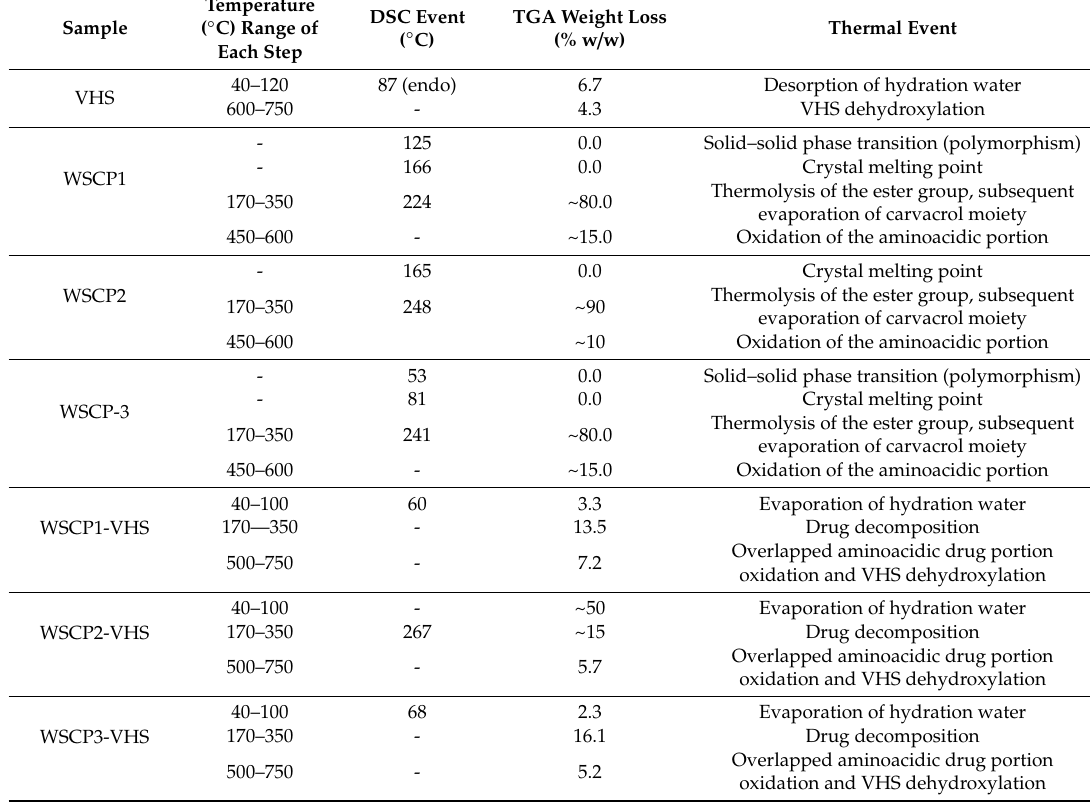
Table 2. Summary of thermal events obtained from TGA and DSC